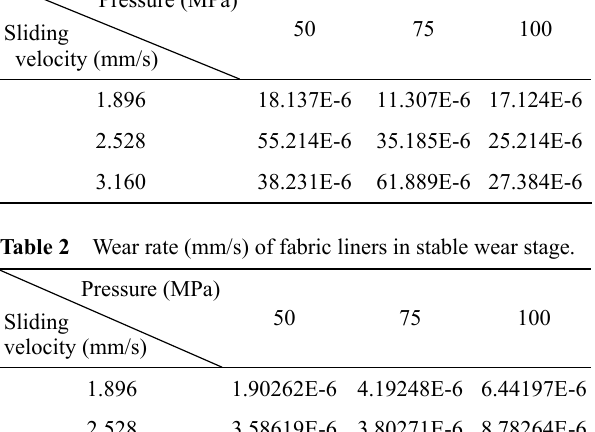
Fig. 2 Variation curves of wear depth of fabric liners under different pressures and velocities: (a) 1.896 mm/s; (b) 2.528 mm/s; and (c) 3.160